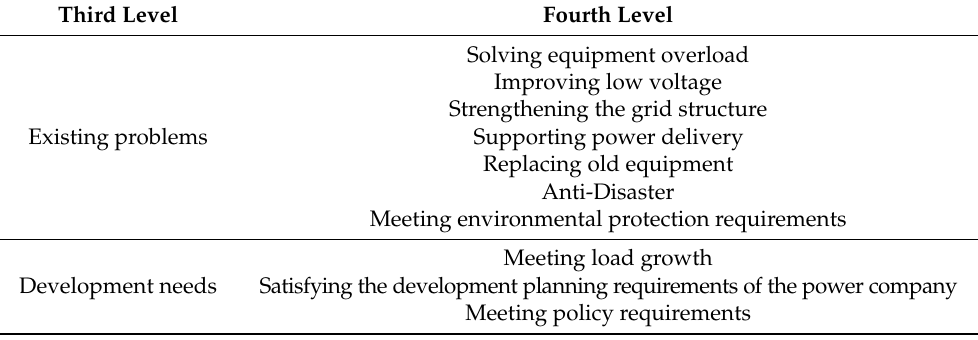
Table 1. Conditions and sub-conditions of necessity.